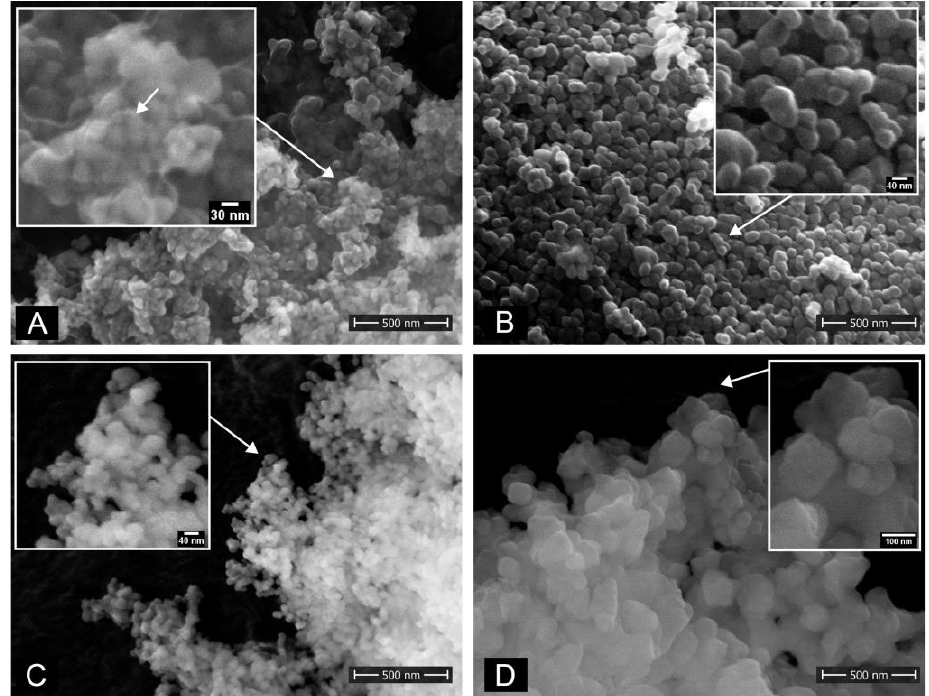
Figure 1. SEM images of plain nanoparticles as received. ( A ) PH particles, ( B ) TZ-0 particles, ( C ) UEP particles, ( D ) TZ-3YSE particles. The arrow in the insert of Figure 1A indicates a possible coating of the particles.